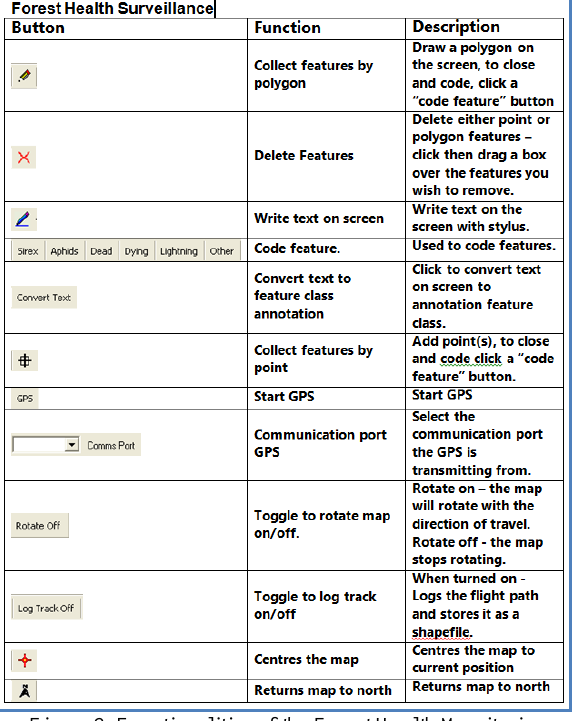
Figure 2. Functionalities of the Forest Health Monitoring System